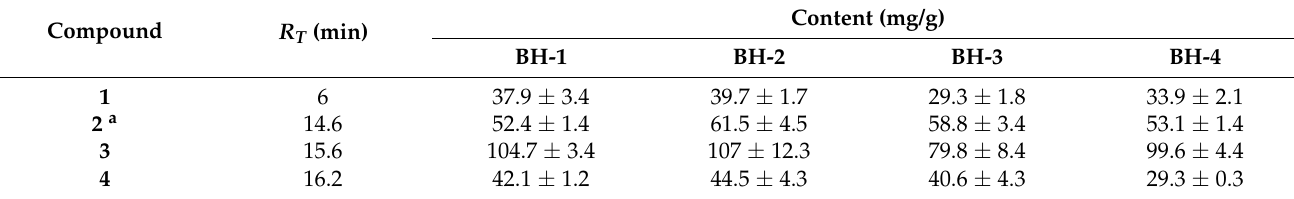
Table 3. Contents (mg/g) compounds in four batches of the B. heterophylla ( n = 3). Compound